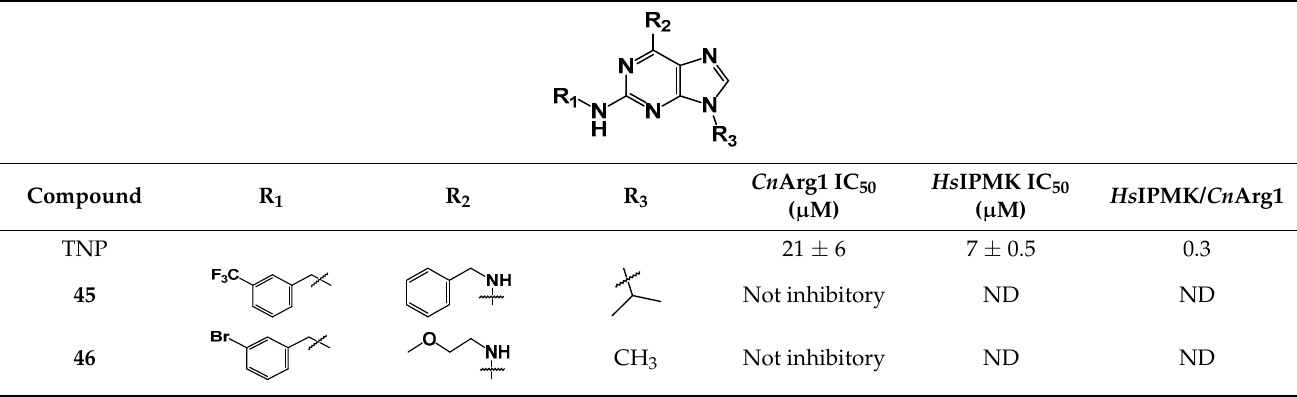
For fixed N 6-amine substitutions, 2-fluoro-6-chloro-9 H -purine, 1 was subjected to consecutive nucleophilic aromatic substitutions (Scheme 1) [37,44,45]. While substitution of 1 occurs in the 6-position preferentially, giving 2 [46], bis-substitution was a common observation initially. Monitoring the temperature and length of the first nucleophilic aro- matic substitution reaction gave improved outcomes. The second substitution at the 2- position yielded the target compounds, 3 but also proved to be challenging, with reactions requiring high reagent concentrations to proceed.